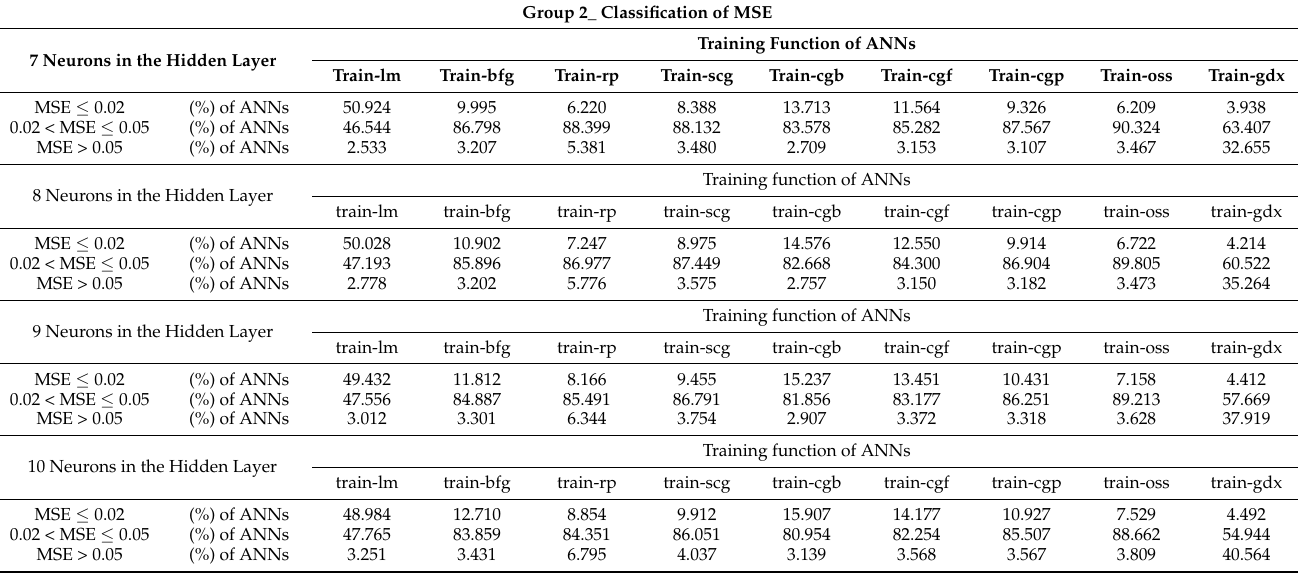
Table 11. Classification of MSE—ANNs with input parameters of Group 2. Group 2_ Classification of